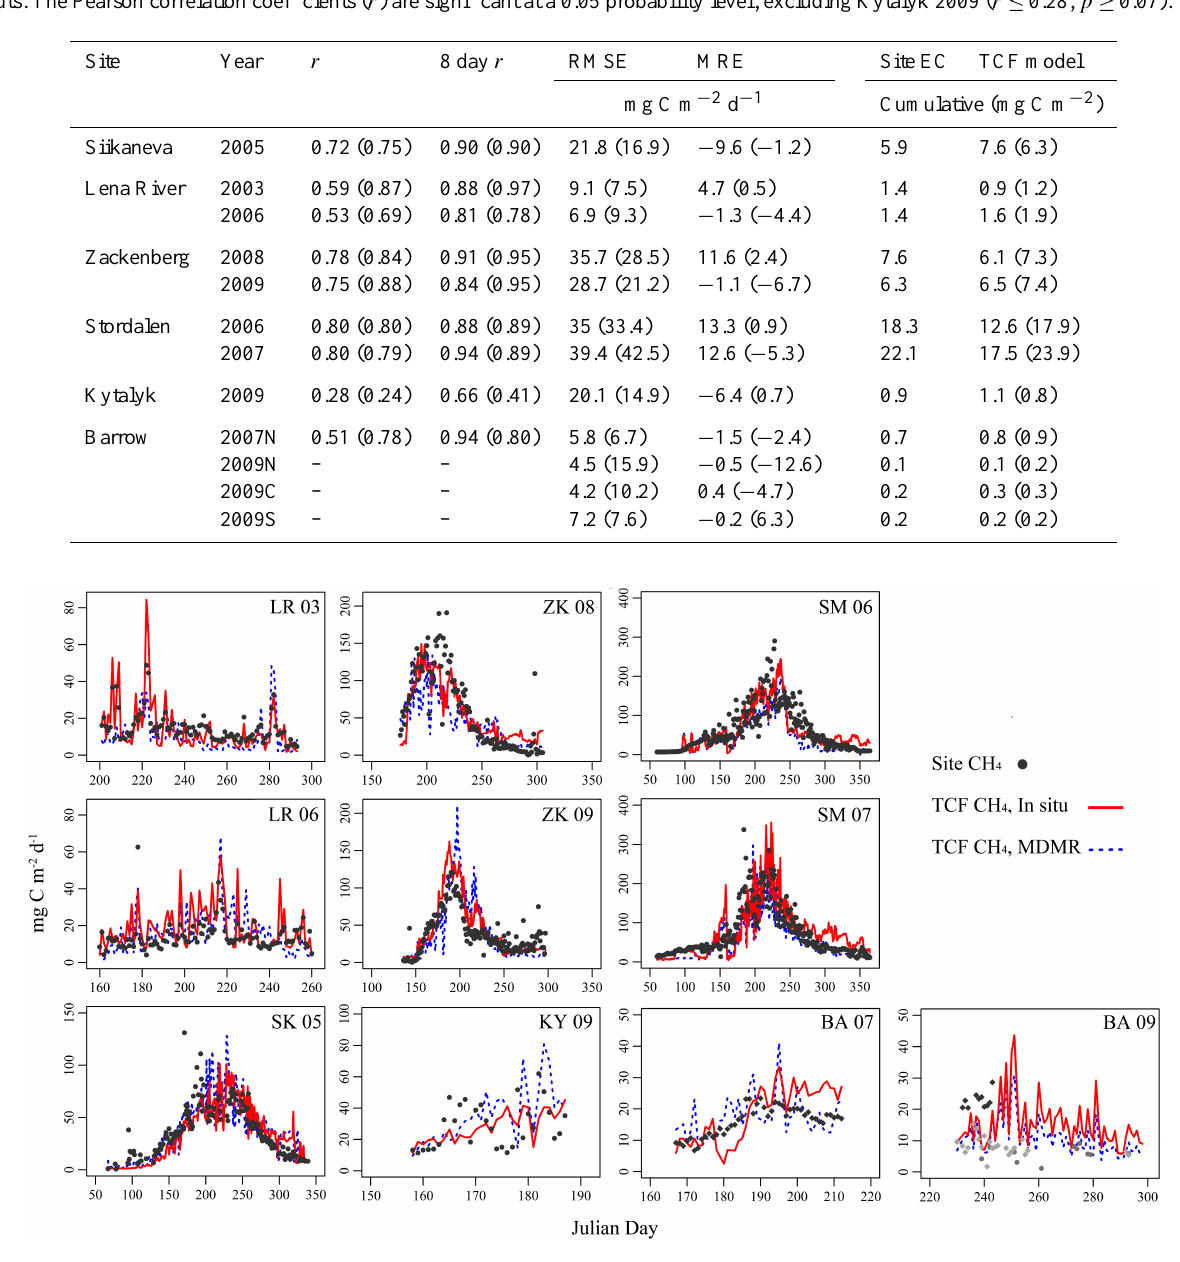
Fig. 6. TCF model CH 4 simulations driven using in situ (solid lines) or input remote sensing and reanalysis (dashed lines) inputs, as compared with tower EC records (circles). For BA 2009, the TCF model results are simulation means for the three Barrow tower sites; diamond shapes indicate CH 4 flux observations from the northern (in dark gray) and central (in light gray) towers, whereas gray circles indicate observations from the southern